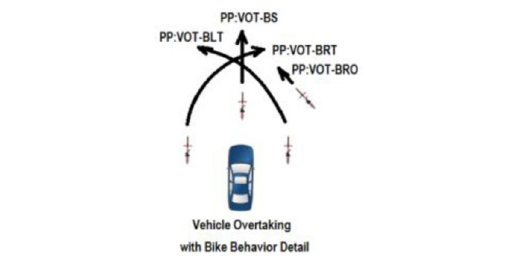
Figure 3 Crash geometry of PP:VOT scenarios